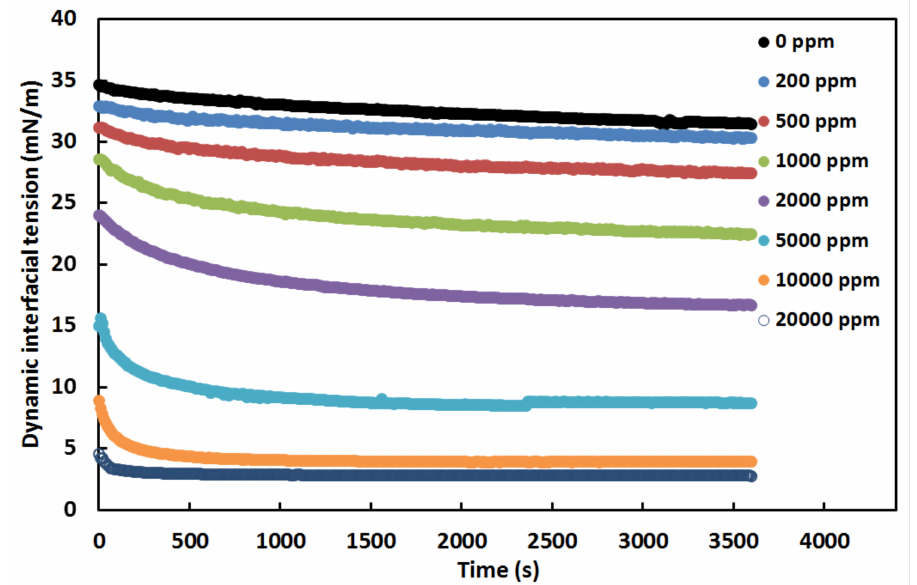
Figure 4. Dynamic crude oil-water interfacial tensions in the presence of nanoparticles at different Span 80